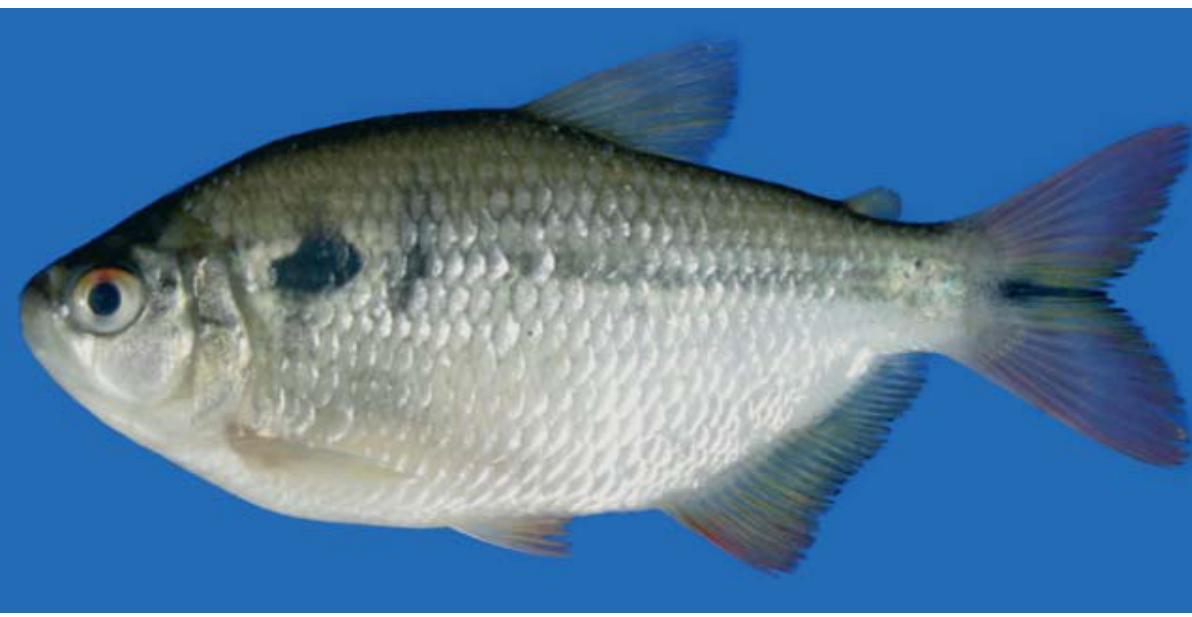
Fig. 2. Astyanax goyacensis Eigenmann, DZSJRP 10857, topotype, 57.1 mm SL, rio Vermelho, Municipality of Goiás, Goiás State, rio Araguaia basin (alcohol preserved